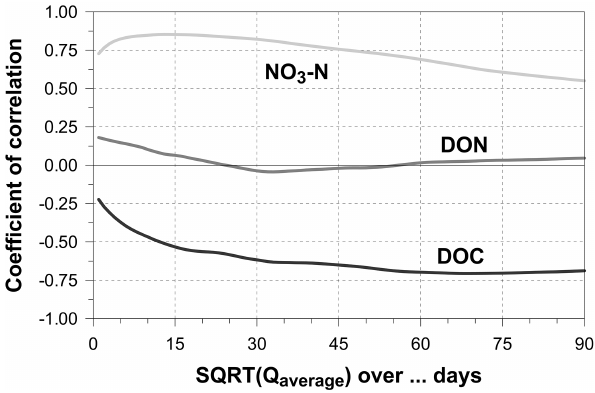
Figure 5. Cross-correlation between the square root of the aver- age discharge Q average in the ditch and the concentrations of dis- solved organic carbon (DOC), dissolved organic nitrogen (DON) and nitrate–nitrogen (NO 3 –N).